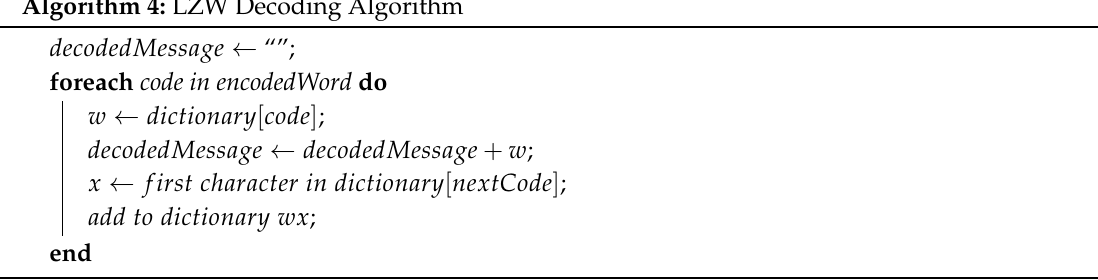
Algorithm 4: LZW Decoding